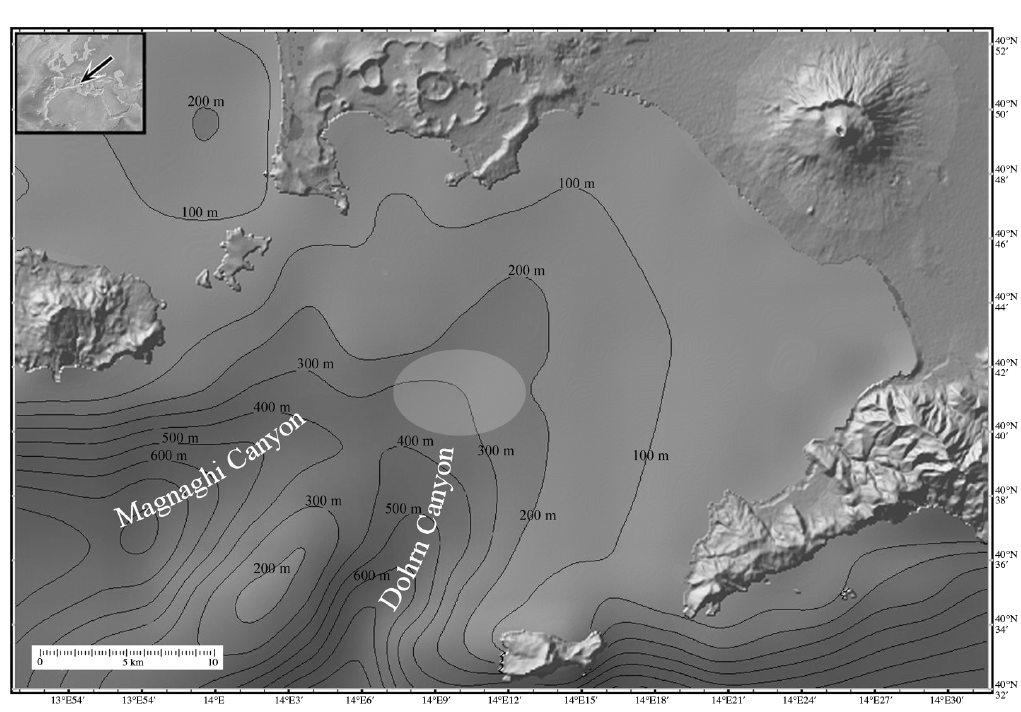
Fig. 1. Bathymetric and topographic image of the Gulf of Naples. A bright ellipse indicates the area of inter- est for our studies, where the researchers of the Anton Dohrn Zoological Station carried out measurements of the physical properties of the seawater in the period from February 2002 to February